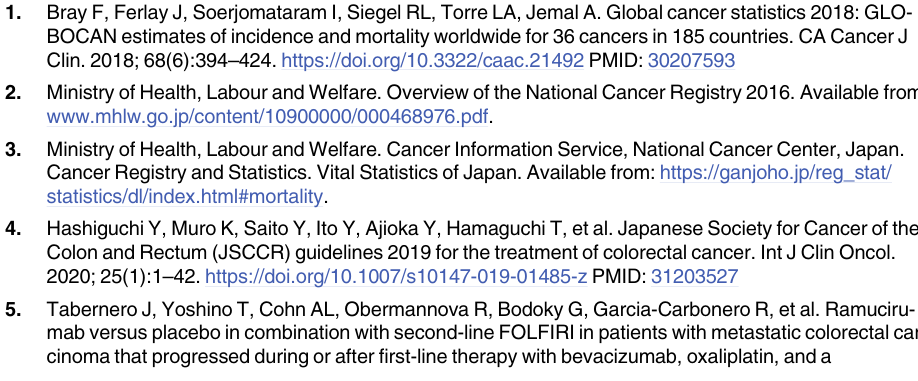
S6C Table. Multivariate Cox regression analysis for the factors associated with overall treatment continuation from the start of second-line therapy to the end of all antitumor drug therapies in the FOLFIRI plus aflibercept beta